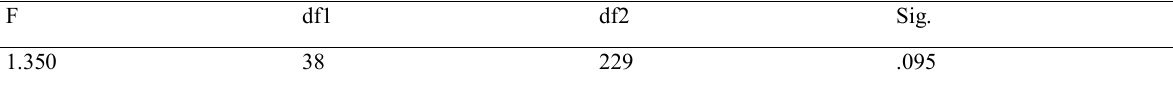
Table 13: Homoscedasticity test for continuous quality